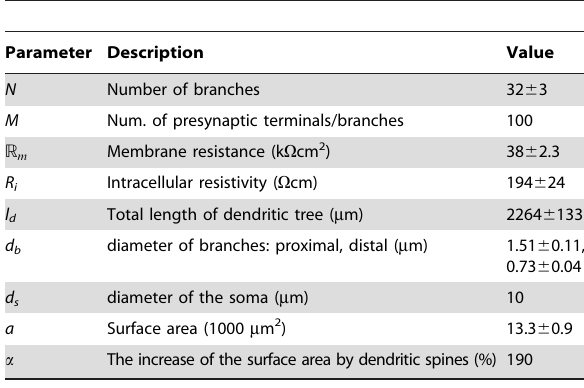
Table 1. Membrane parameters of hippocampal granule